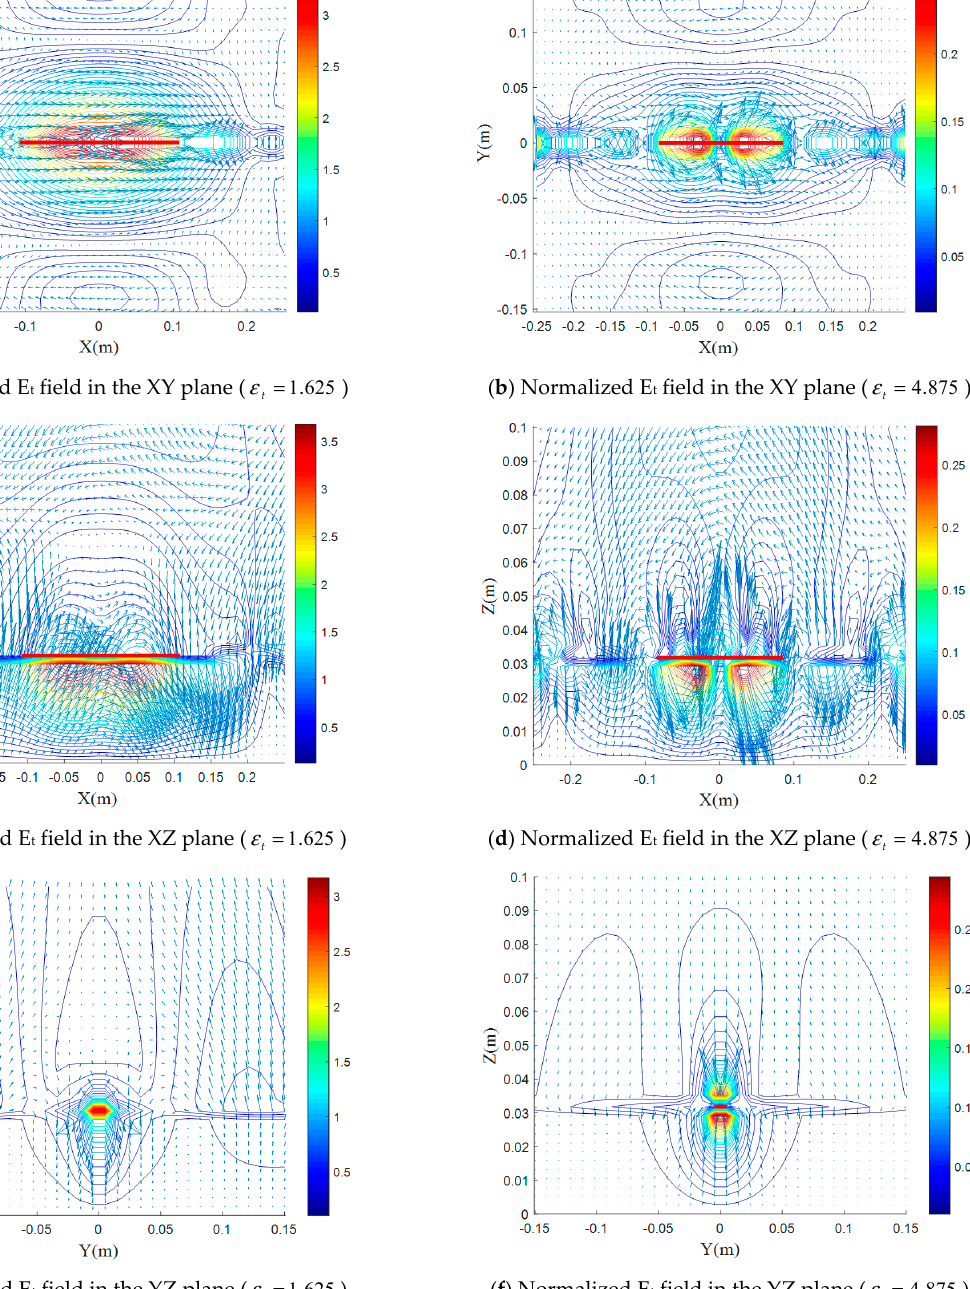
Figure 5. ( a – f ) Normalized electric field distributions for various values of ε t with ε z = 3.25, µ z = 1 and µ t = 1 in the XY, XZ, and YZ planes.